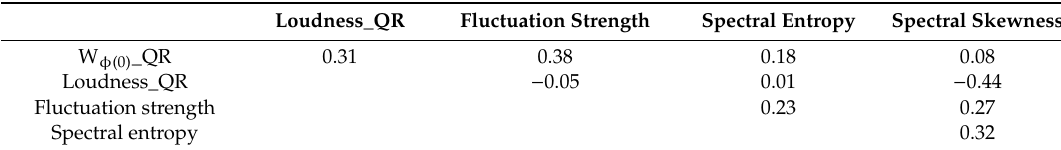
Table 4. The correlation coe ffi cients between the explanatory variables used in the multiple regression analysis in the equal L Aeq condition for insect songs.